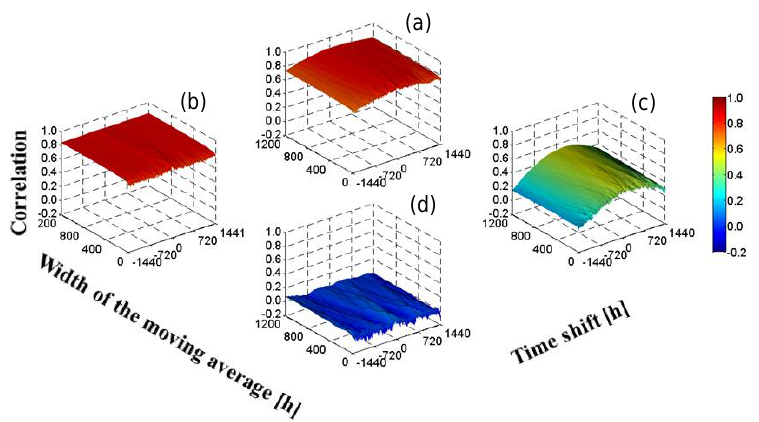
Figure 13. Surface plots of the correlation of the NDIR CO 2 measurements vs. the FTIR CO 2 measurements. The x axis corresponds to the time shift, the y axis to the width of the moving average and the z axis to the correlation between the FTIR and the NDIR data set, the color code illustrates the correlation and corresponds to the z axis values. (a) The FTIR CO 2 measurements vs. the corresponding NDIR CO 2 measurements including the annual CO 2 increase as well as the seasonality; (b) as (a) but without seasonality; (c) as (a) but detrended; (d) as (a) but detrended and